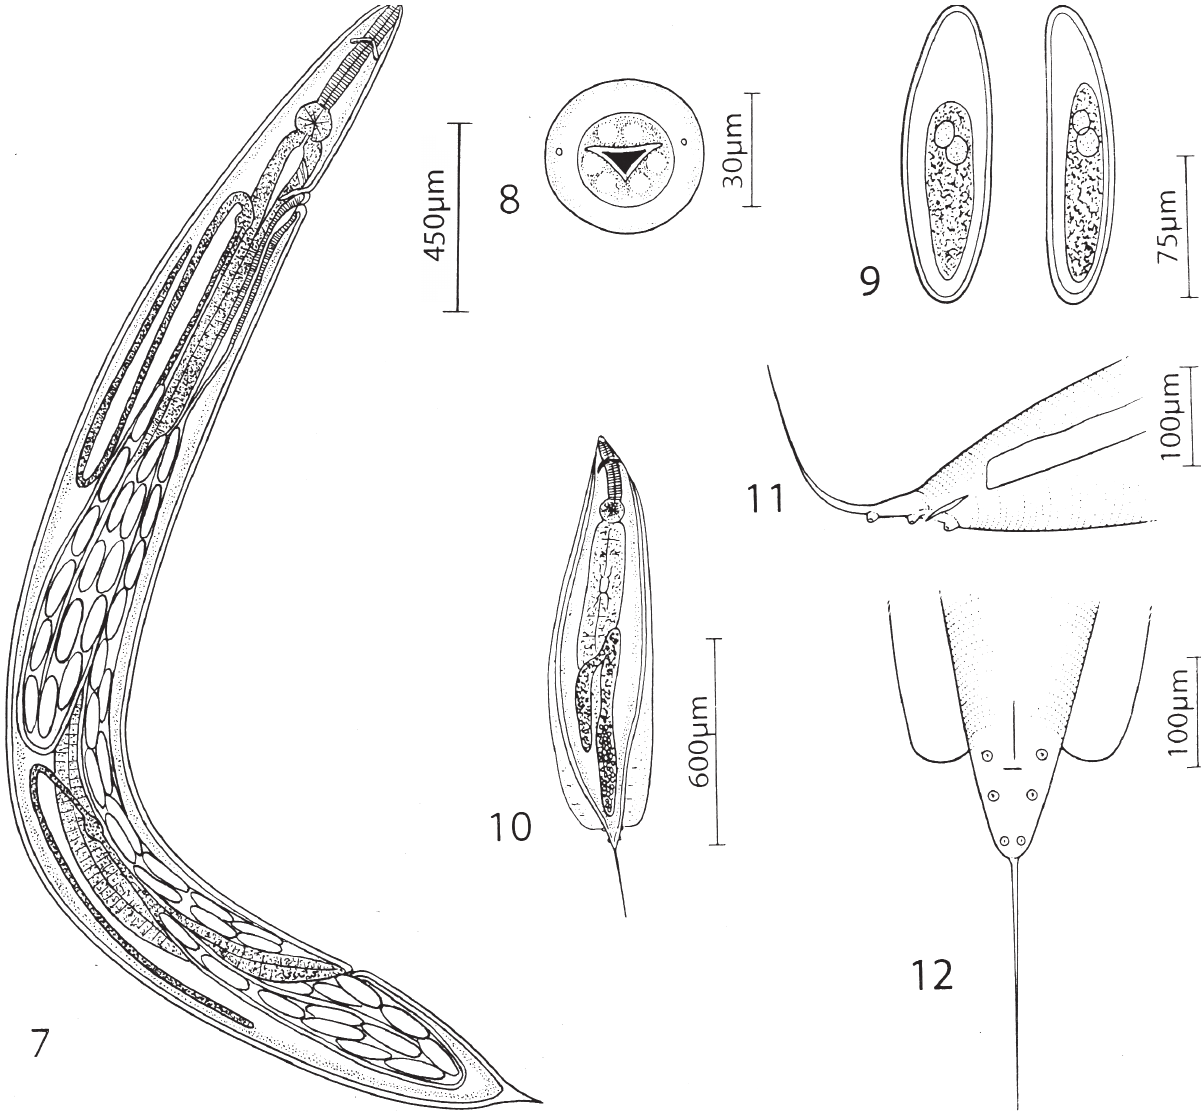
caudal papillae. Single tubular testis reflexed posterior to excretory